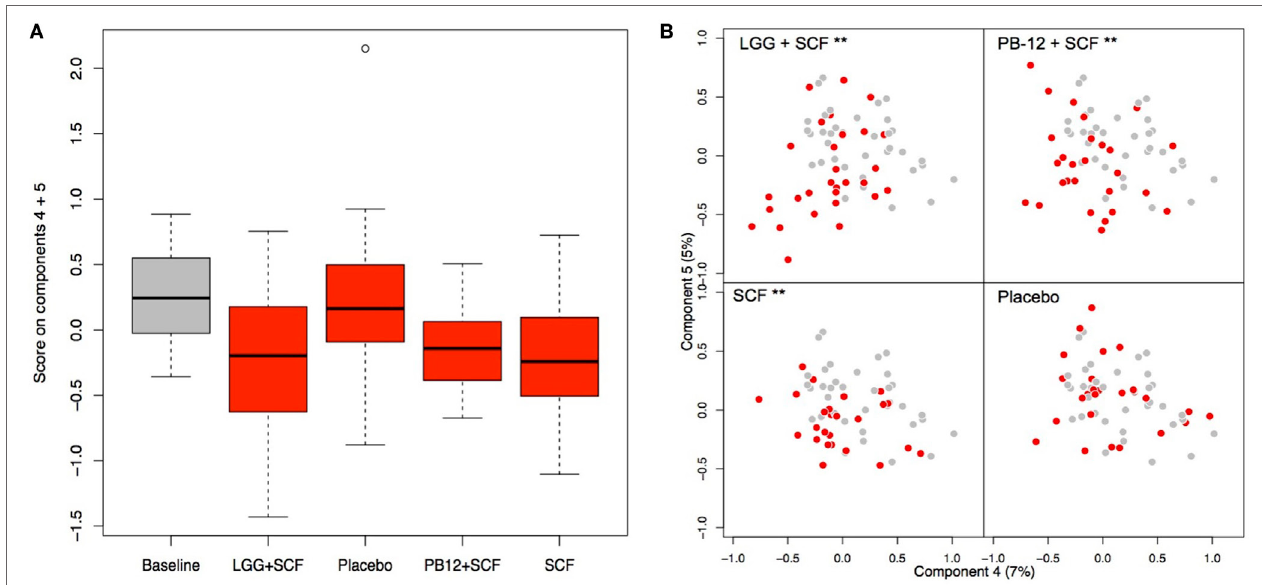
FiGUrE 5 | Principal coordinate analysis (PCoA) of the fecal microbiota composition in each group after the treatments. (a) Score on components 4 and 5 in the PCoA plots shown as a box plot; (B) PCoA plots indicating the shift between baseline samples (gray) and treatment samples (red) of each participant arm: LGG + Soluble Corn Fiber (SCF)**, PB12 + SCF**, SCF** (** p = 0.001), and placebo ( p =